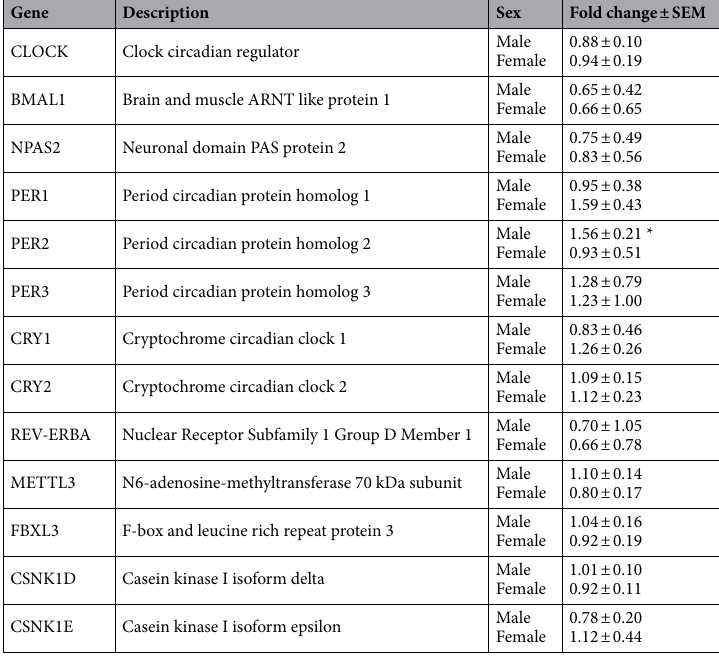
Table 6. Circadian rhythm gene panel RT-qPCR results. mRNA levels in the livers of 19 week old prenatally Dex-exposed offspring relative to saline control. Fold changes in gene expression were calculated by relative quantification (ΔΔCt) of RT-qPCR threshold cycles (Ct) as per Livak and Schmittgen 28 using mean Ct values of housekeeping genes GAPDH and Rpl32. Data is expressed as mean fold change of Dex relative to the saline group ± SEM (n = 8). Unpaired t-test: Statistical significance between groups is shown by: * p < 0.05.